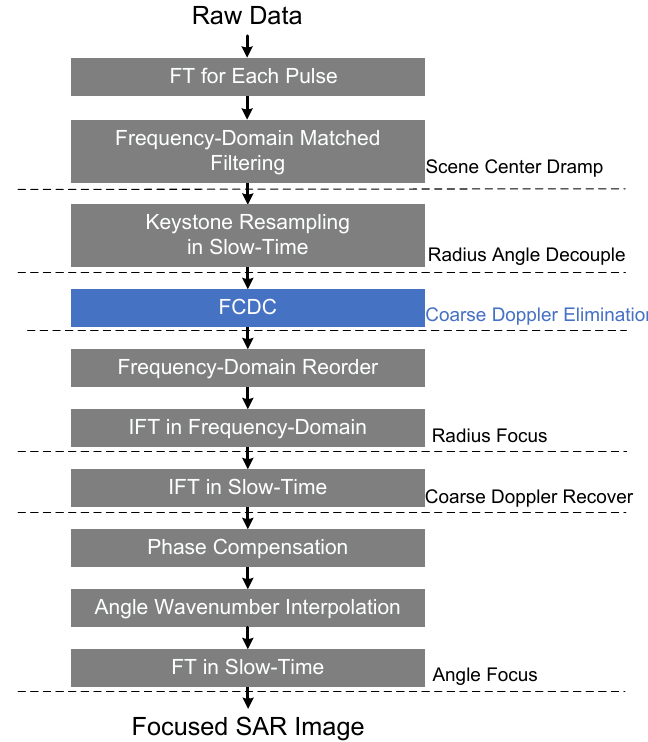
Figure 8. Flowchart of the coherent imaging processing.